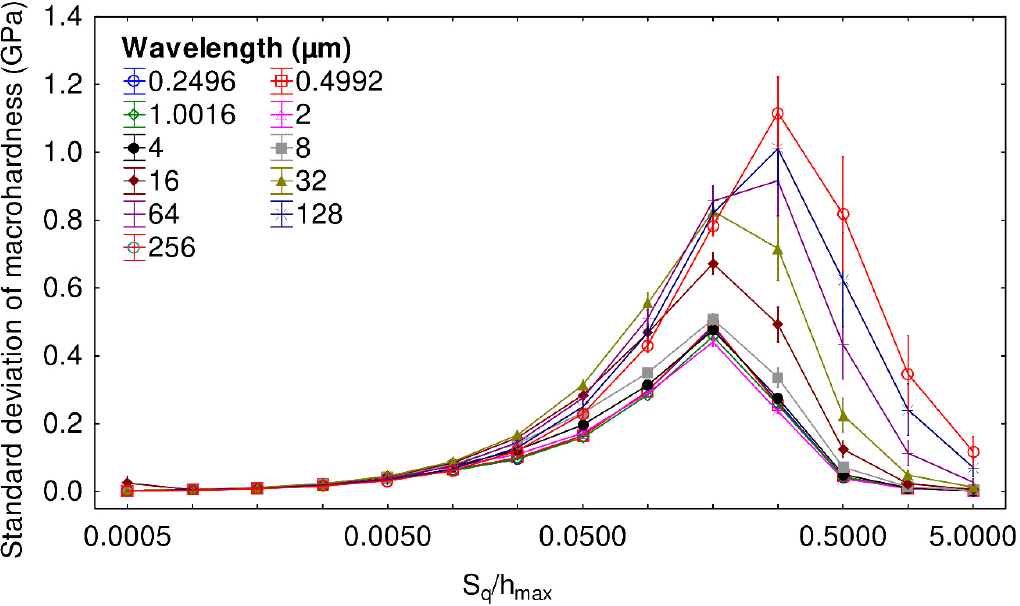
Figure 6. Standard deviation of macrohardness as a function of the ratio S q / h max for di ff erent values of wavelengths. The mesh size and fractal dimension of the tested surfaces are, respectively, set to 256 × 256 and 2.5.